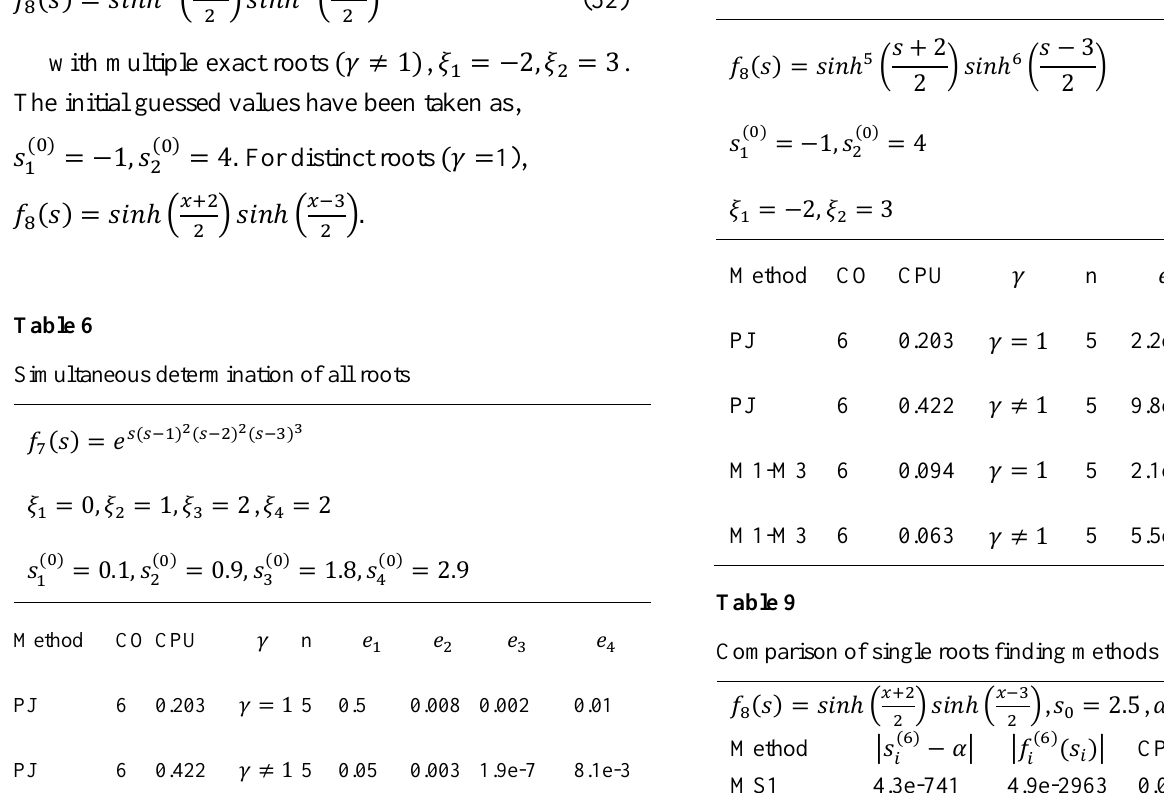
Simultaneous determination of all roots